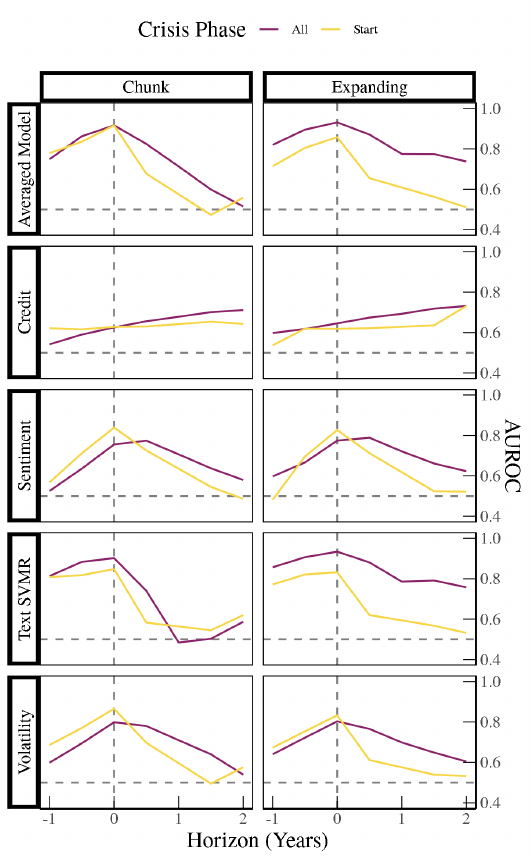
Figure 21. Crisis Phase: Starts vs. All . Note: This figure shows area under the ROC curve (AUROC) for models based on OECD text and Romer and Romer (2017) 5+ severity for backcasting and forecasting horizons of − 1 to 2 years (at half-year frequency) for the “chunk” and “expanding” methods for the full set of crisis phases (i.e., “All”) and observations that indicate the onset of crisis phases (i.e., “Start”). For the most part, all models are better at predicting “All” crisis phases versus “Start” crisis phases. The Sentiment, SVM, Volatility, and Averaged Model (average of SVM Radial, Sentiment, and Volatility Models) all perform better at nowcasting the onset of crises compared to backcasting and forecasting, and struggle the most in forecasting the exact timing of the onset of a crisis, especially from one to two years out. On the other hand, the Credit Models perform relatively better at forecasting crises one to two years out, whether using the chunk method or the expanding method, with an AUC of between 0.60 and 0.80 compared to other models; moreover, they perform the best out of all the models at forecasting the onset of crises two years